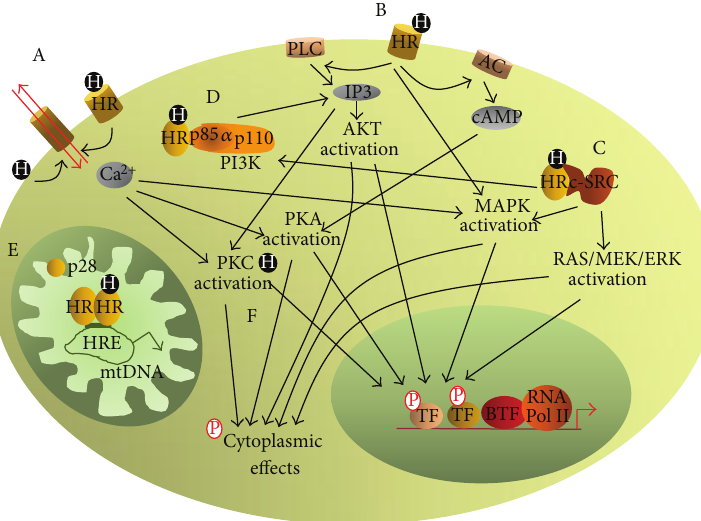
Figure 6: Simplified diagram of nongenomic mechanisms of action of small-molecule hormones. All nongenomic mechanisms activate numerous transduction pathways, and, by a series of phosphorylation events of cytoplasmic and of nuclear proteins, modify cell function. (A) Interaction of the hormone with either cell membrane receptor or directly with membrane phospholipids modifies the function of ion channels. (B) Activation of phospholipase (C) initiated by the hormone-activated cell membrane receptor, and of adenylate cyclase (and, most possibly, of other enzymes) stimulates production of secondary messengers. (C) Activation of c-SRC by the hormone-activated nuclear receptor. (D) The binding of the hormone-activated nuclear receptor to the phosphatidylinositol 3 kinase p85 𝛼 subunit activates this enzyme and results in an increased synthesis of inositol triphosphate. (E) In mitochondria, small-molecule hormones acting via their nuclear receptors or by their shorter (mitochondrial) isoforms regulate transcription of mitochondrial DNA. In addition, interaction of some hormones alone or of hormone-receptor complexes with mitochondrial proteins stimulates thermogenesis. (F) The binding of the hormone activates protein kinase. (C) HR: various types of hormone receptors, Ca 2+ : calcium ion, p85 𝛼 , p110: phosphatidylinositol 3 kinase subunits, PI3K: phosphatidylinositol 3 kinase, IP3: inositol triphosphate, PLC: phospholipase. (C) AC: adenylate cyclase, cAMP: cyclic AMP, AKT: protein kinase. (B) c-SRC: tyrosine kinase, PKA: protein kinase. (A) PKC: protein kinase. (C) MAPK: mitogen-activated protein kinase, RAS/MEK/ERK: protein kinases, p28: shortest isoform of TR 𝛼 , mtDNA: mitochondrial DNA, HRE: hormone response element, TF: transcription factor, BTF: basal transcription factors, and RNA Pol II: type II RNA